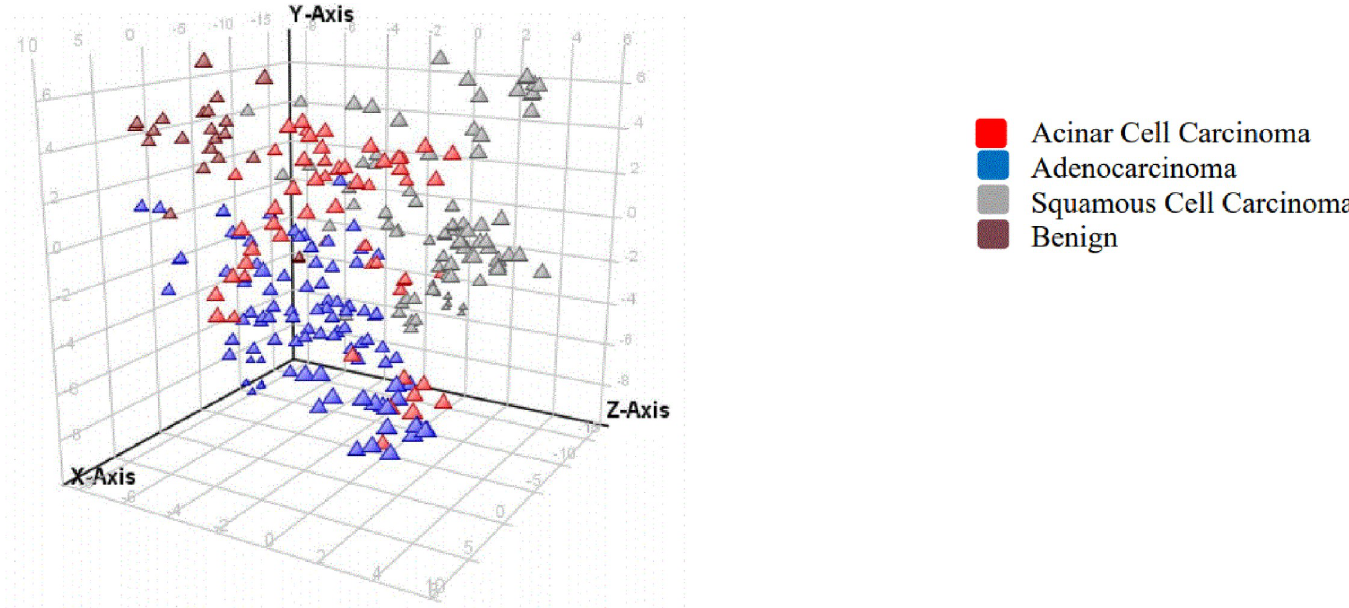
Fig 4. An overview of the t-scores from partial least squares discrimination (PLSD) analyses of plasma metabolites in cancer patients in ESI negative. Each triangle represents an individual patient (triplicate extraction and analysis).